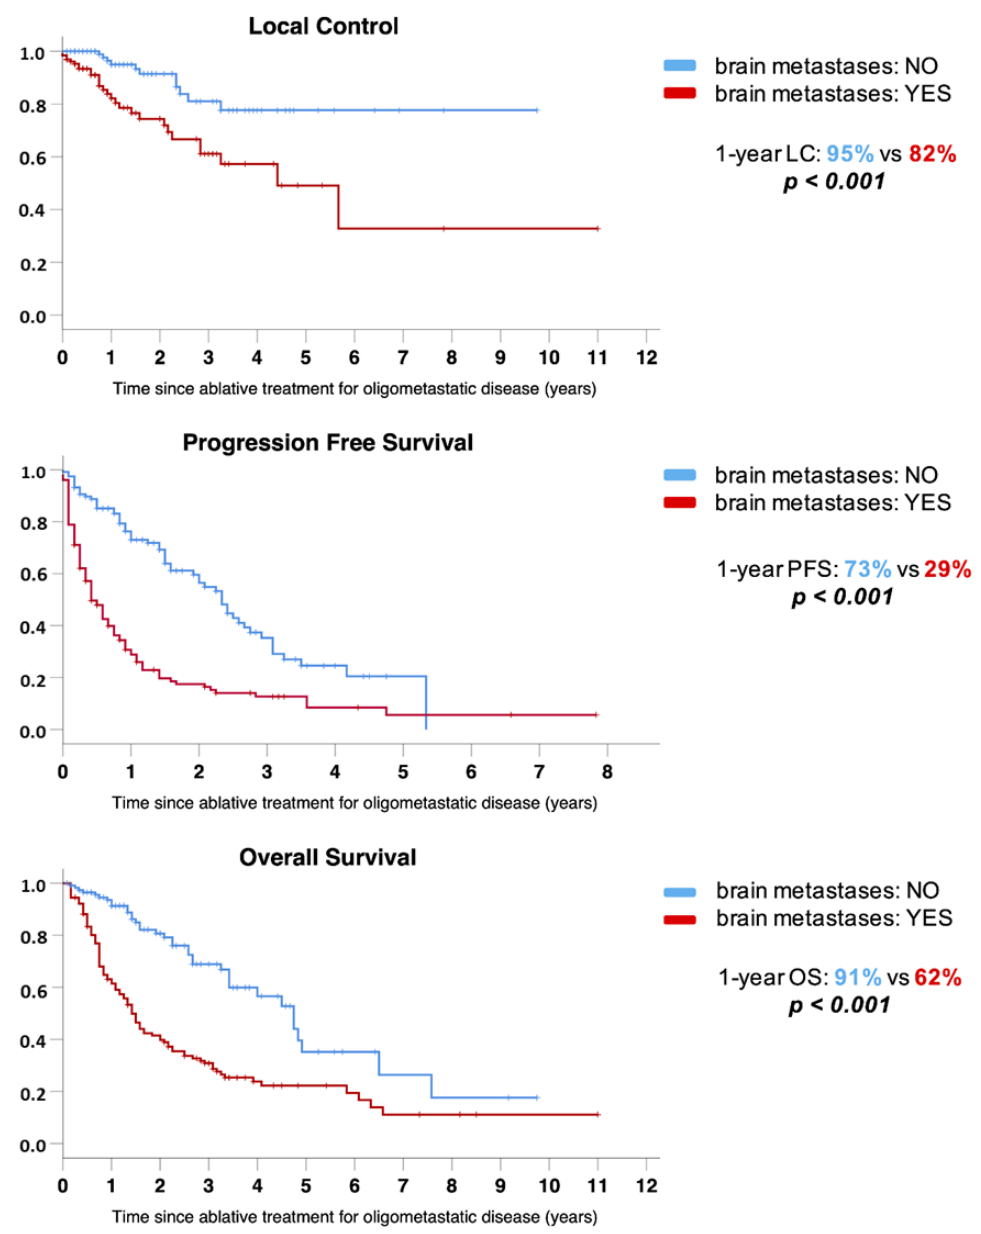
Figure 2. Outcomes stratified by the presence of intracranial disease involvement. Upper chart: LC; middle chart: PFS; lower chart: OS.